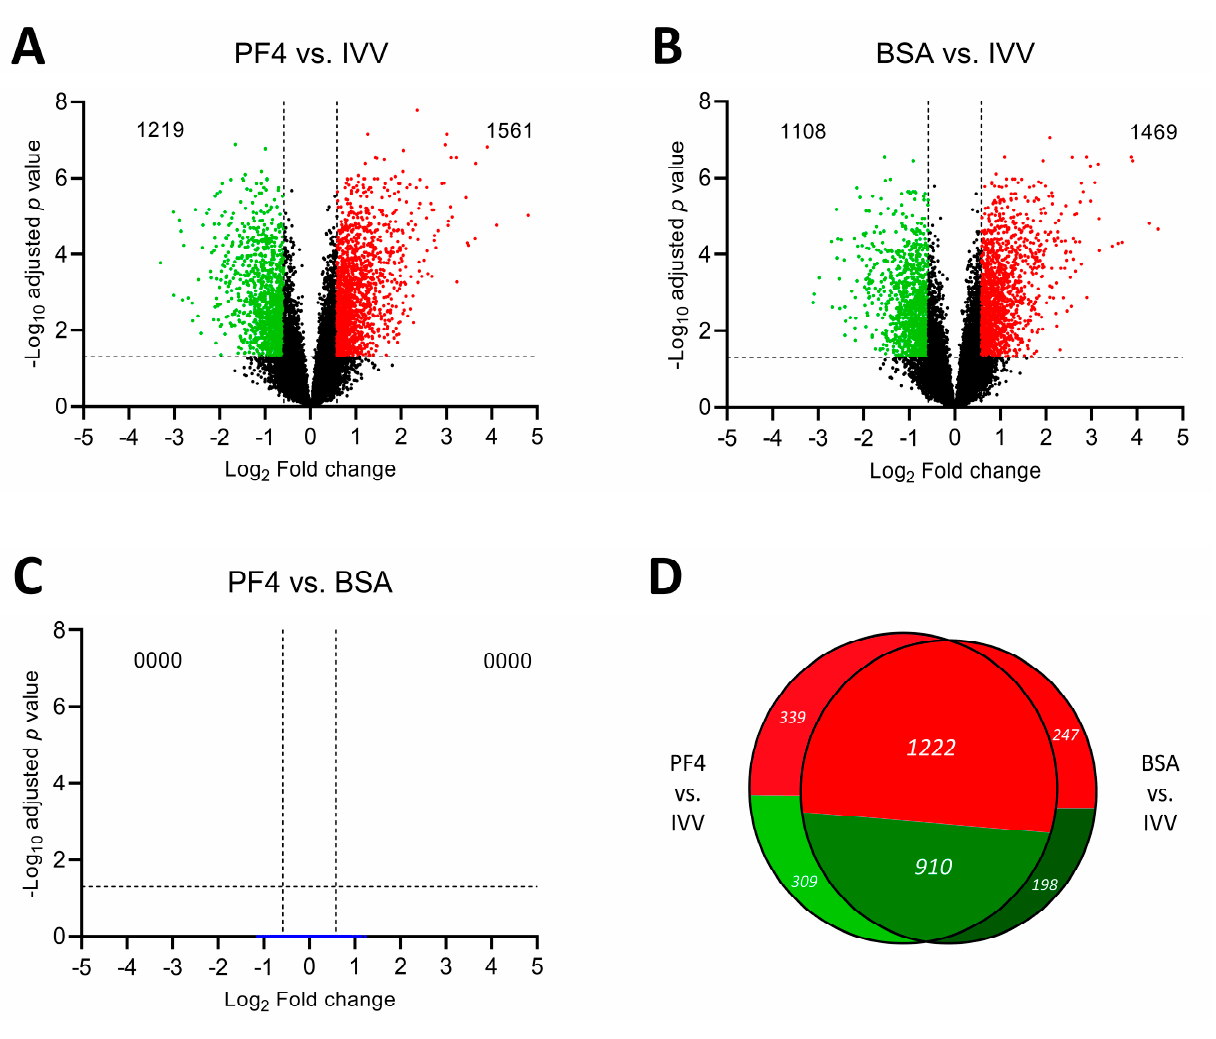
Figure 3. Differentially expressed genes (DEGs) represented by a volcano plot of each pairwise comparison. ( A ) Comparison between in vitro embryos cultured in defined medium (PF4: platelet factor 4) versus in vivo-derived embryos (IVV). ( B ) Comparison between in vitro embryos cultured in undefined medium (BSA: bovine serum albumin) versus IVV embryos. ( C ) Comparison between PF4 and BSA embryos. ( D ) Venn diagram comparison showing the cross-analysis of the DEG obtained from each in vitro group comparison against the IVV group.